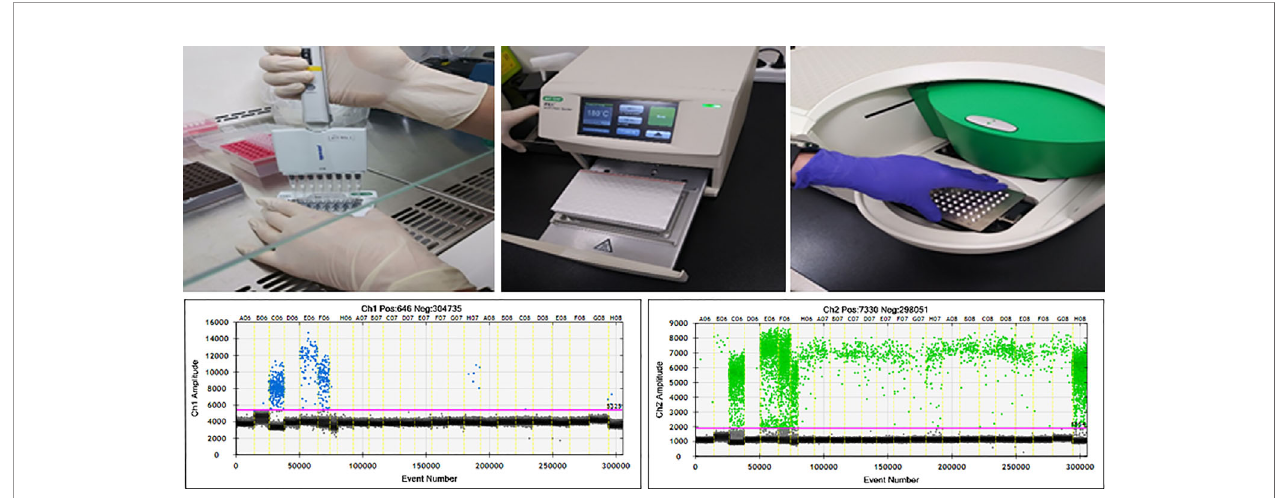
FIGURE 1 | ddPCR work fl ow and results of ddPCR for detection of KRAS G12/13 . Channel 1: fl uorescence measurement of mutant probe labeled with 6 ‐ fl uorescein amidite (FAM) (lower left). Channel 2; wild-type probe labeled with hexachloro fl uorescein (HEX) (lower